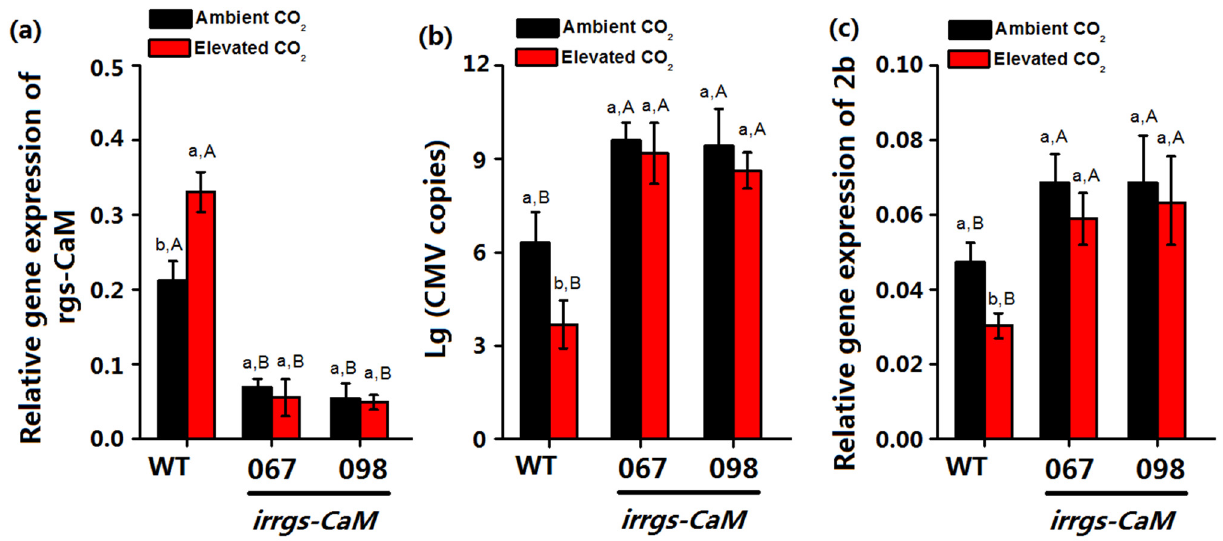
Figure 5. ( a ) relative gene expression of rgs-CaM ( b ) CMV copy numbers and ( c ) the relative expression of 2b mRNA in WT and irrgs-CaM (line067, line098) N. tabacum plants post agroinoculated with CMV for 14 days under ambient CO 2 and elevated CO 2 . Data represent means ± SE (Tukey’s multiple range test, p < 0.05). Different lowercase letters indicate significant differences between CO 2 levels within the same genotype. Different uppercase letters indicate significant differences among three genotype within the same CO 2 level.